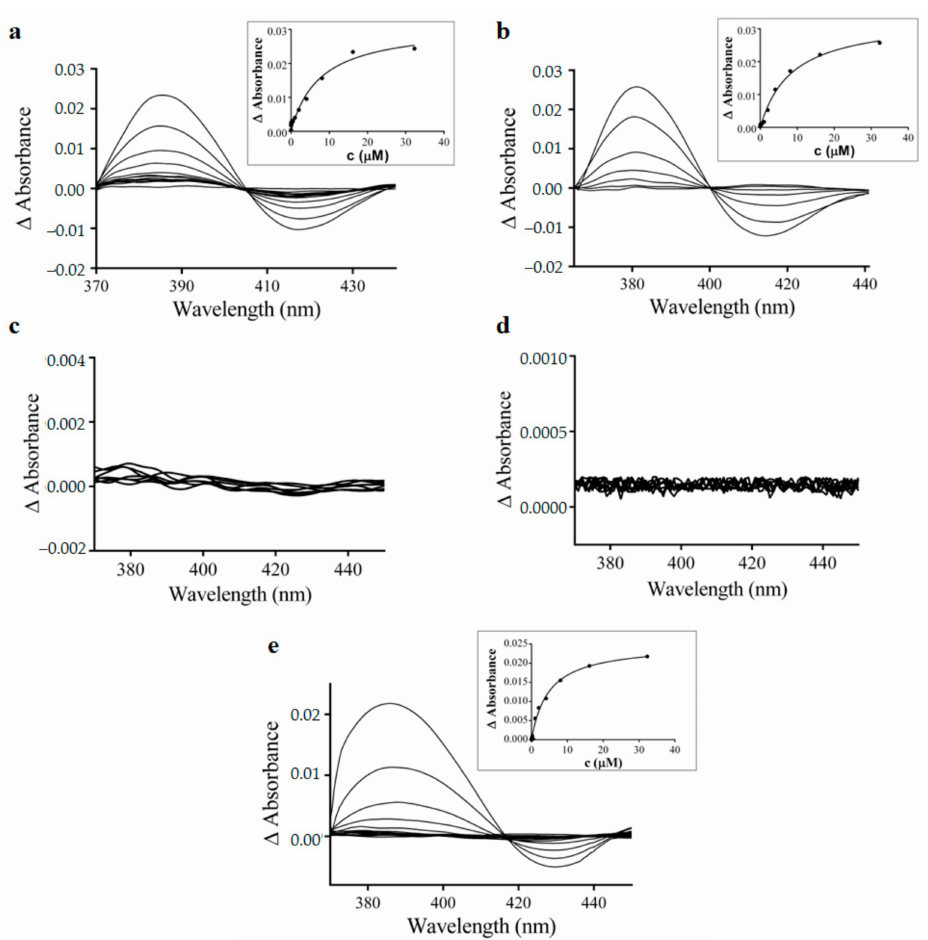
Figure 5. Difference spectra demonstrating the interaction of human liver microsomal cytochrome P450s with complex 1 ( a ), complex 2 ( b ), free Hqui ligand ( c ), free mphen ligand ( d ), and Cu(NO 3 ) 2 · 3H 2 O ( e ). CYPs concentration was 1 µ M, and the concentrations of the tested complexes varied from 0.002 to 33.310 µ M. Insets: plots of the absorbance changes at 386 nm vs. concentration of the respective